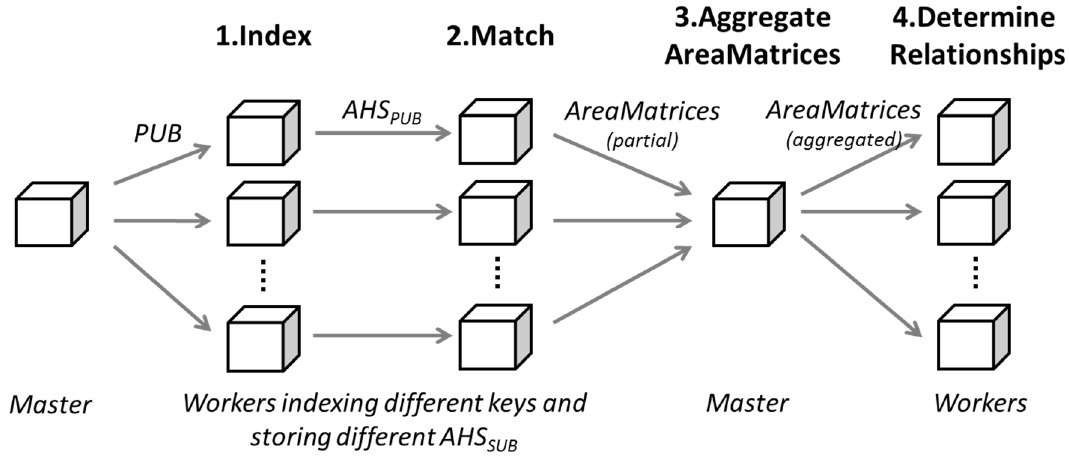
Figure 3. High-level architecture and workflow of the distributed AHS model.